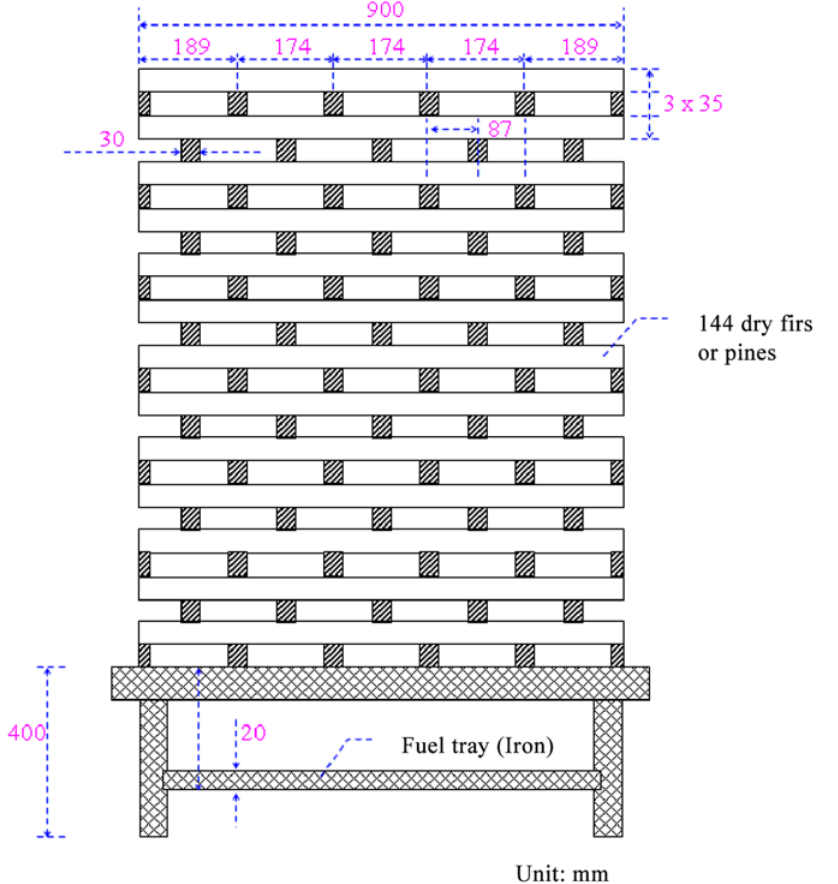
Fig 2. Wood model (for experiment).